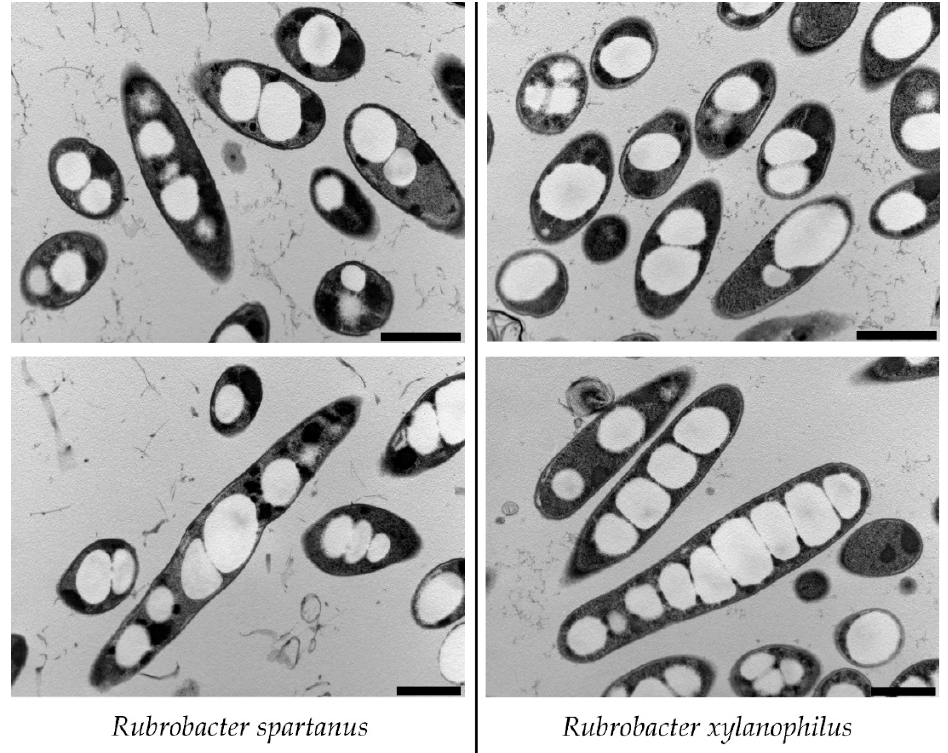
Figure 1. Morphology of bacterial strains R. spartanus ( left ) and R. xylanophilus ( right ) as seen by transmission electron microscopy, scale 1 μ m.